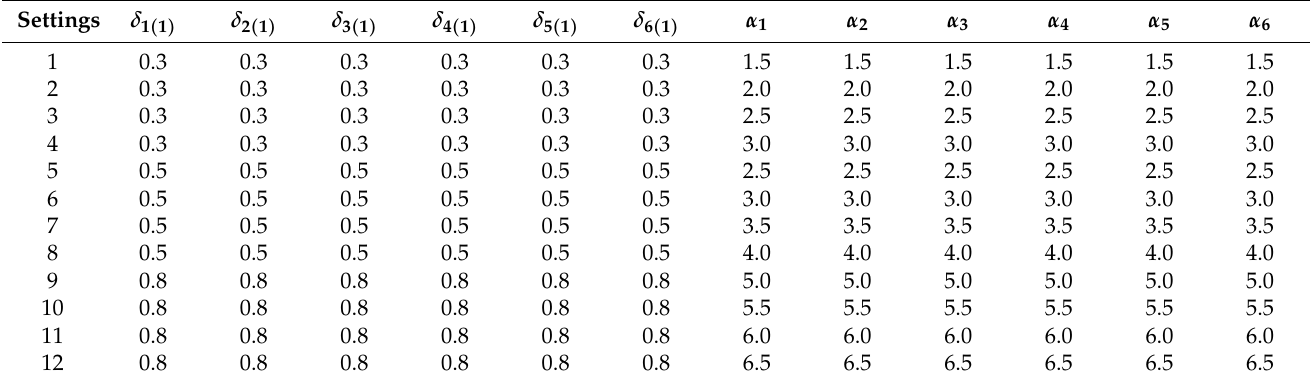
Table 2. Simulation study parameter settings for δ i ( 1 ) , α i , and β i = 1 with k =